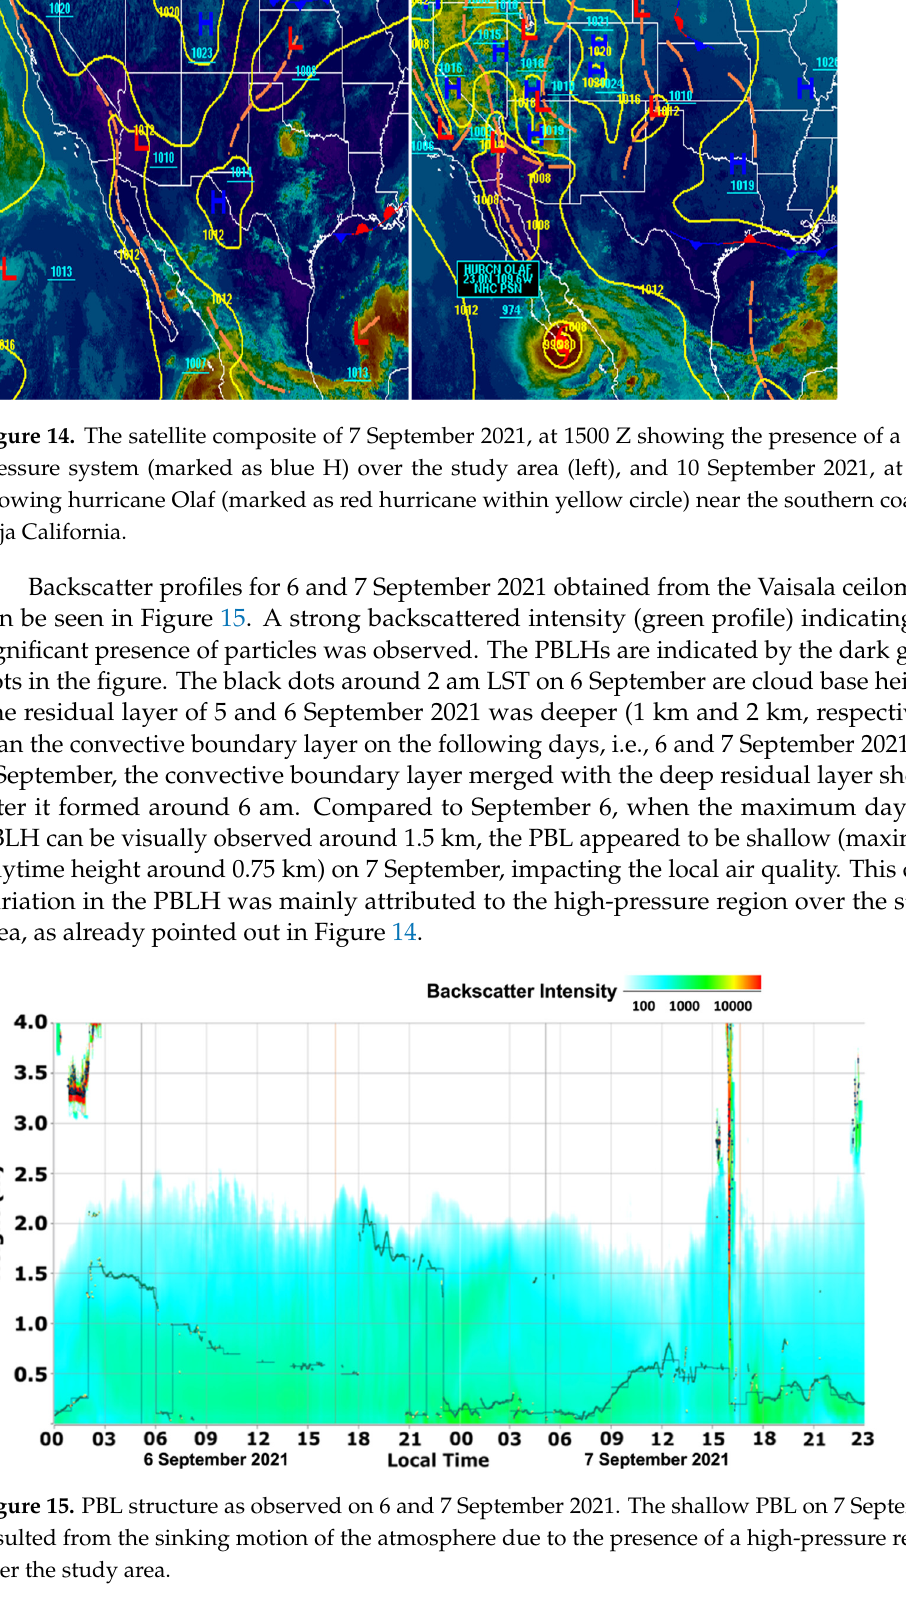
Figure 15. PBL structure as observed on 6 and 7 September 2021. The shallow PBL on 7 September resulted from the sinking motion of the atmosphere due to the presence of a high-pressure region over the study area.